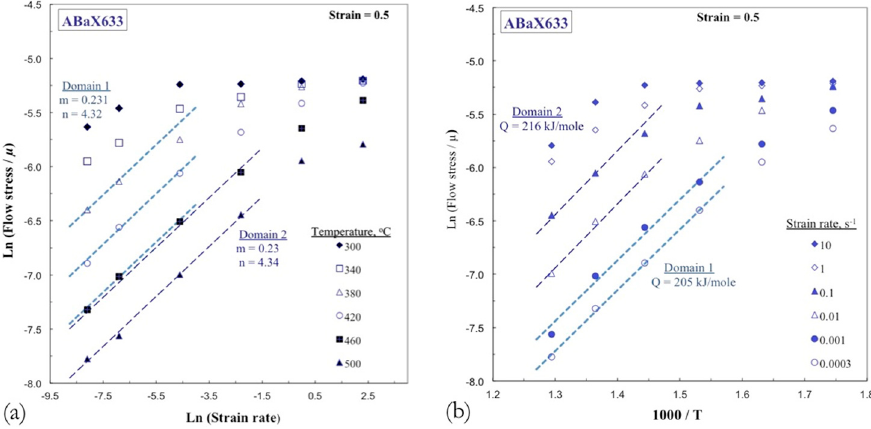
Figure 8. For ABaX633 specimens at a strain of 0.5: ( a ) Variation of the flow stress with strain rate; ( b ) Arrhenius plots showing the variation of normalized flow stress with inverse of absolute temperature.